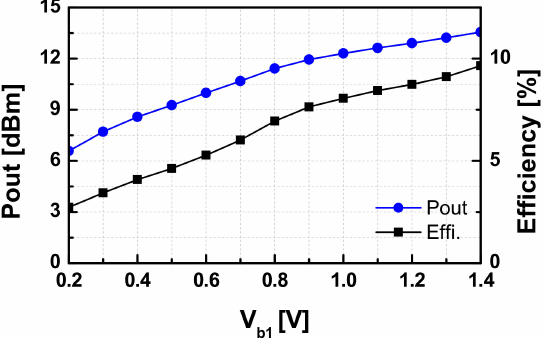
Figure 17. The measured output power and efficiency of the VCO versus bias voltage V b1 = V C(coarse) . Table 2. Comparison of state-of-the-art VCOs around